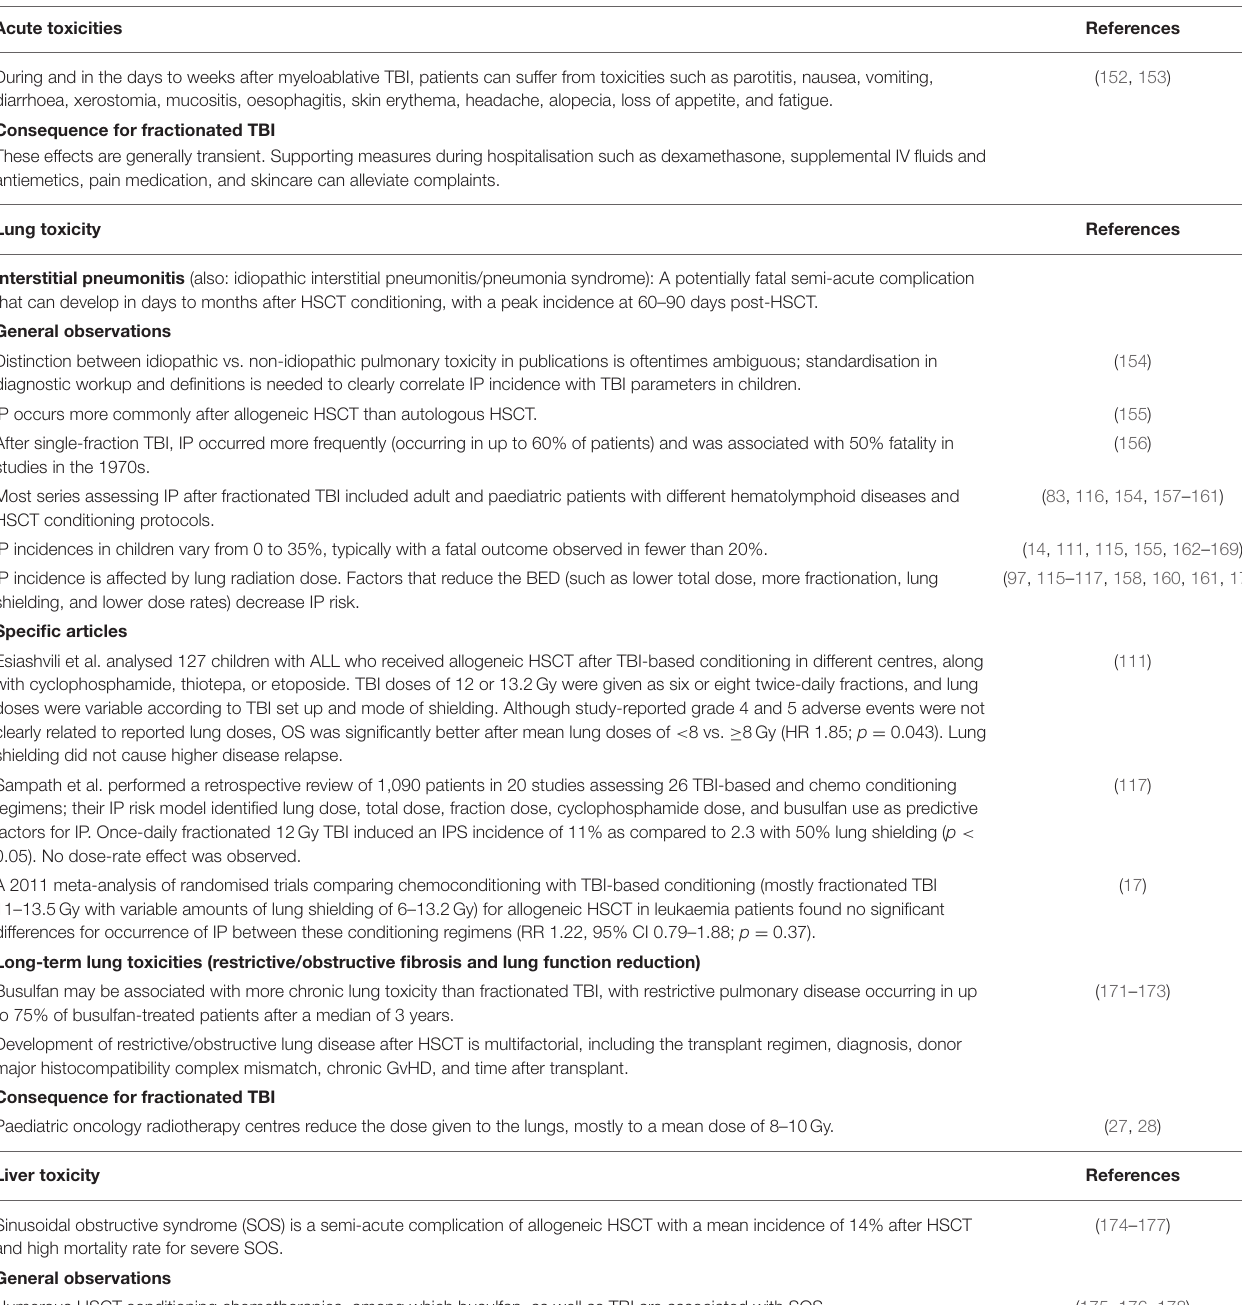
TABLE 1 | Fractionated TBI related effects after